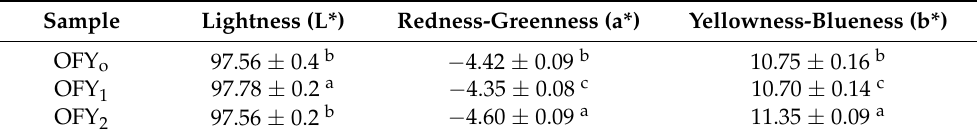
Table 2. Color properties of simple yogurt (OFYo), yogurt with probiotic (OFY 1 ), and okara forti- fied yogurt (OFY 2 ).